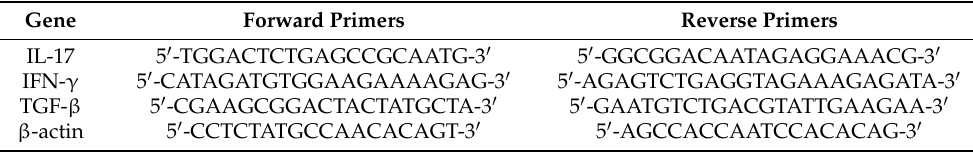
Table 1. Sequences of PCR